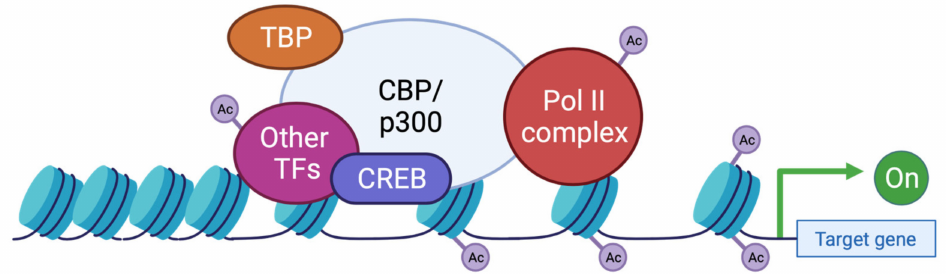
Figure 4. Functions of CBP/p300 as scaffold, bridge, and lysine acetyl transferase (KAT) activity. CBP and p300 act as transcriptional co-activators of target genes by different mechanisms: (1) Scaffolding function allowing the recruitment of transcription factors (TF) and in particular CREB; (2) Binding function by facilitating the physical and functional interactions of TFs; (3) KAT function by catalyzing the transfer of acetyl groups on lysine residues of both histone tails and non-histone proteins such as the RNApolIIcomplex and TFs. TBP: TATA binding protein; TF: transcription factor; Ac: acetyl